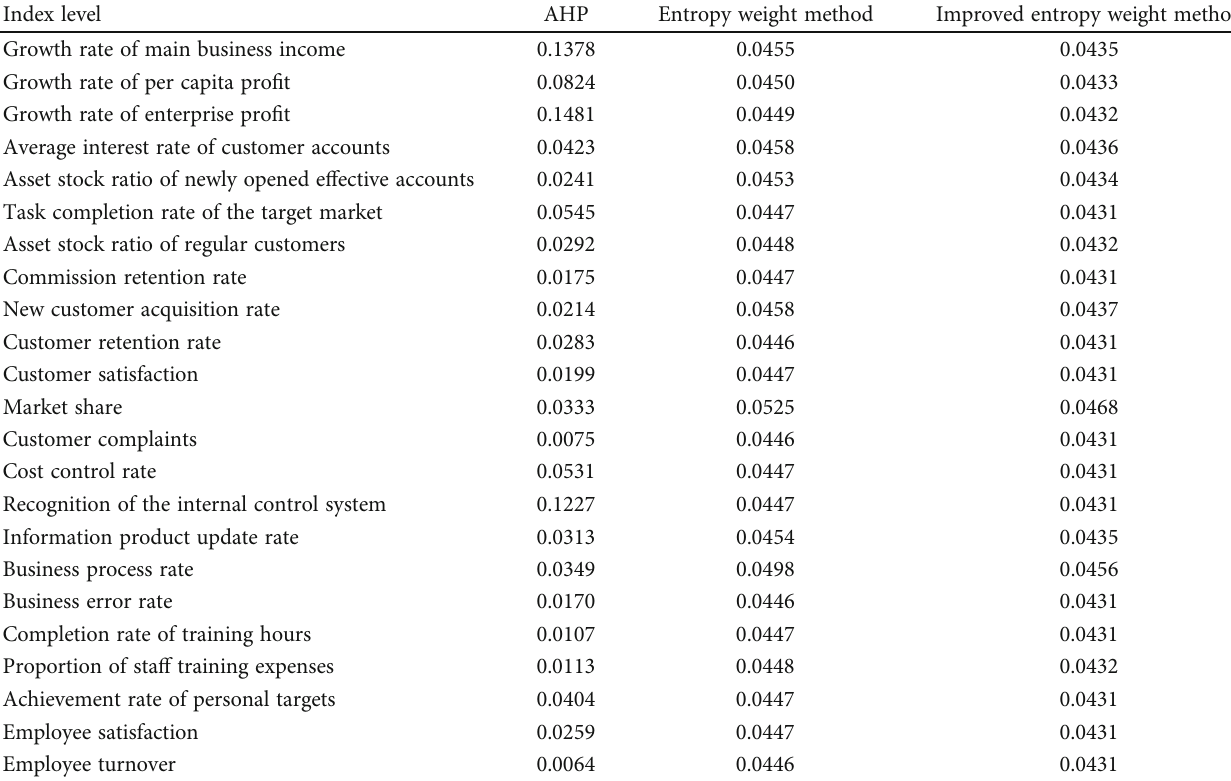
Table 4: Weights of performance evaluation of securities